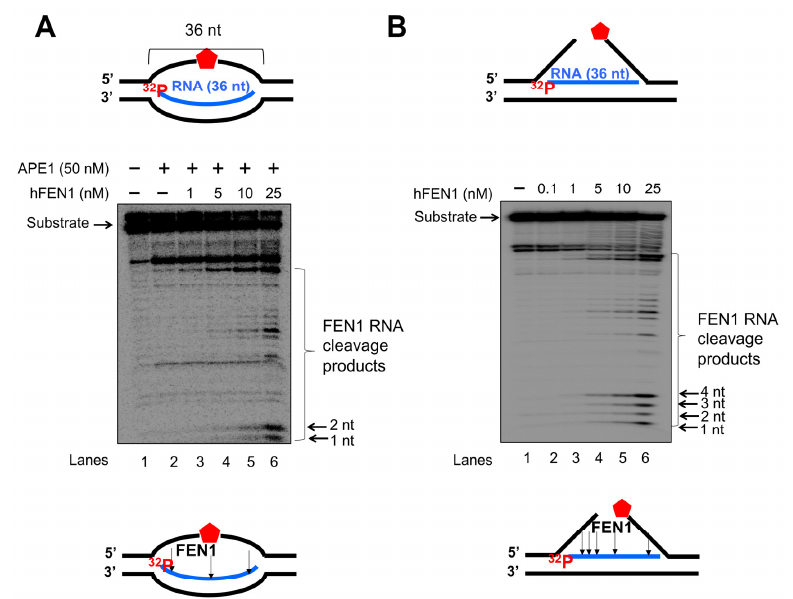
Figure 5. FEN1 cleavage of RNA on R-loop intermediates during BER. FEN1 cleavage on the RNA strand on an R-loop during BER was examined using the substrate containing an abasic site in the non-template strand ( A ) or substrate containing a 3 (cid:48) - and 5 (cid:48) -flap ( B ) that mimics the intermediate generated from the 5 (cid:48) -incision of an abasic site on the non-template strand of an R-loop. ( A ) FEN1 cleavage (1–25 nM) on the RNA strand of the R-loops in the presence of 50 nM APE1. Lane 1 represents substrate only. Lane 2 represents APE1 cleavage of the abasic site on the non-template strand of the R-loop. Lanes 3–6 represents FEN1 cleavage activity on the RNA strand at different concentrations. ( B ) FEN1 cleavage (0.1–25 nM) on the RNA strand of the double-flap intermediate generated by BER in R-loop. Lane 1 represents substrate only. Lanes 2–6 represents the reaction mixture with FEN1 at different concentrations. Substrates 25 nM were 32 P-labeled at the 5 (cid:48) -end of the RNA strand. Substrates and products were separated in a 15% urea-denaturing polyacrylamide gel and detected by phosphorimagery. The experiments were done in triplicate.